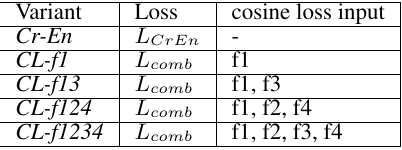
Table 2. Variants for comparisons related to the cosine loss.